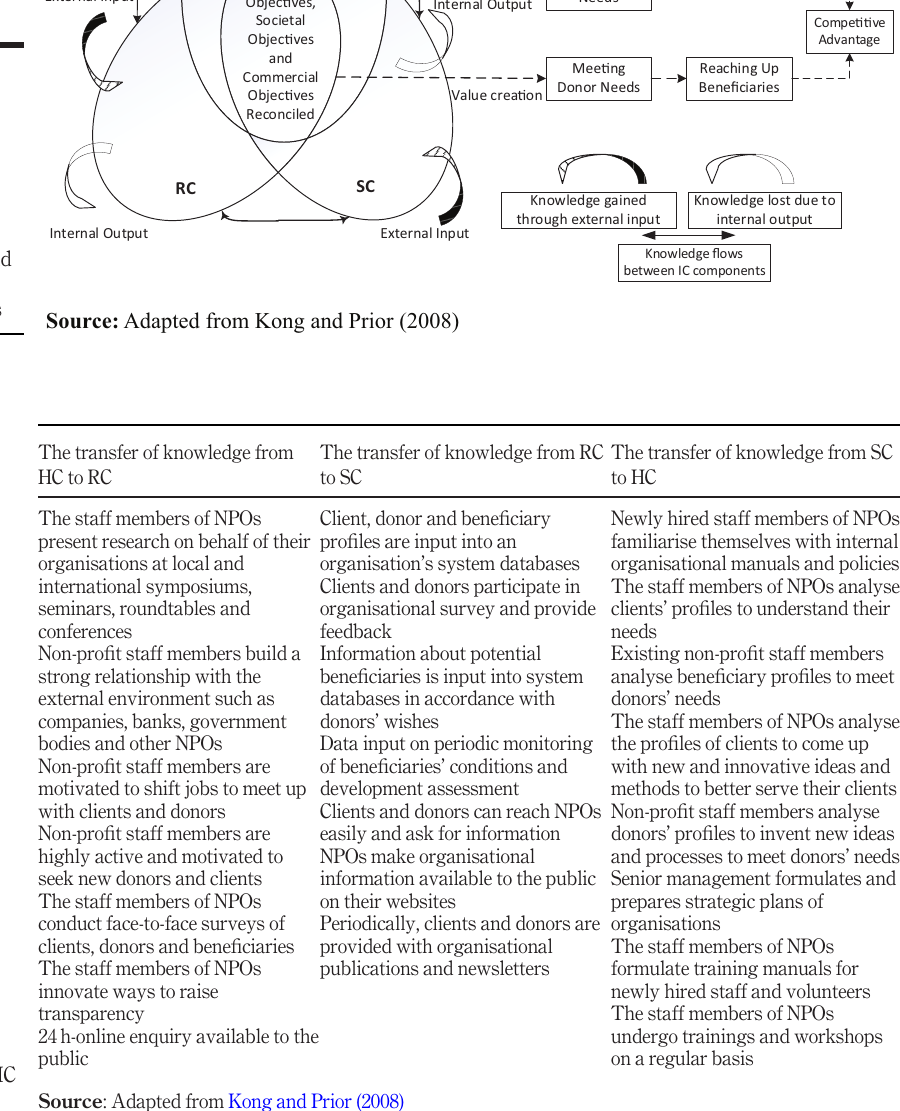
Table I. Value creation examples through the interactions of IC